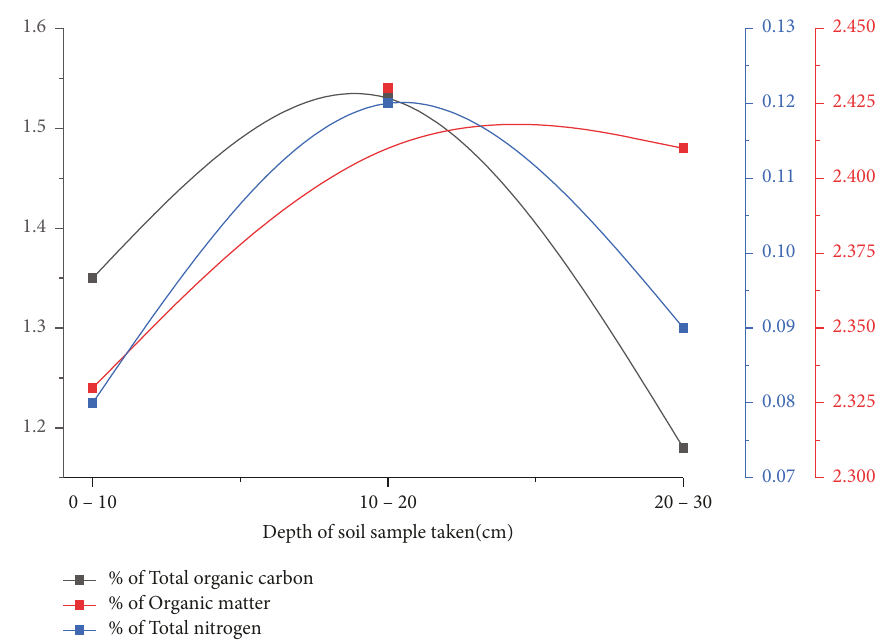
Figure 6: Total organic carbon percent, organic matter percent, and total nitrogen percent vs. depth.